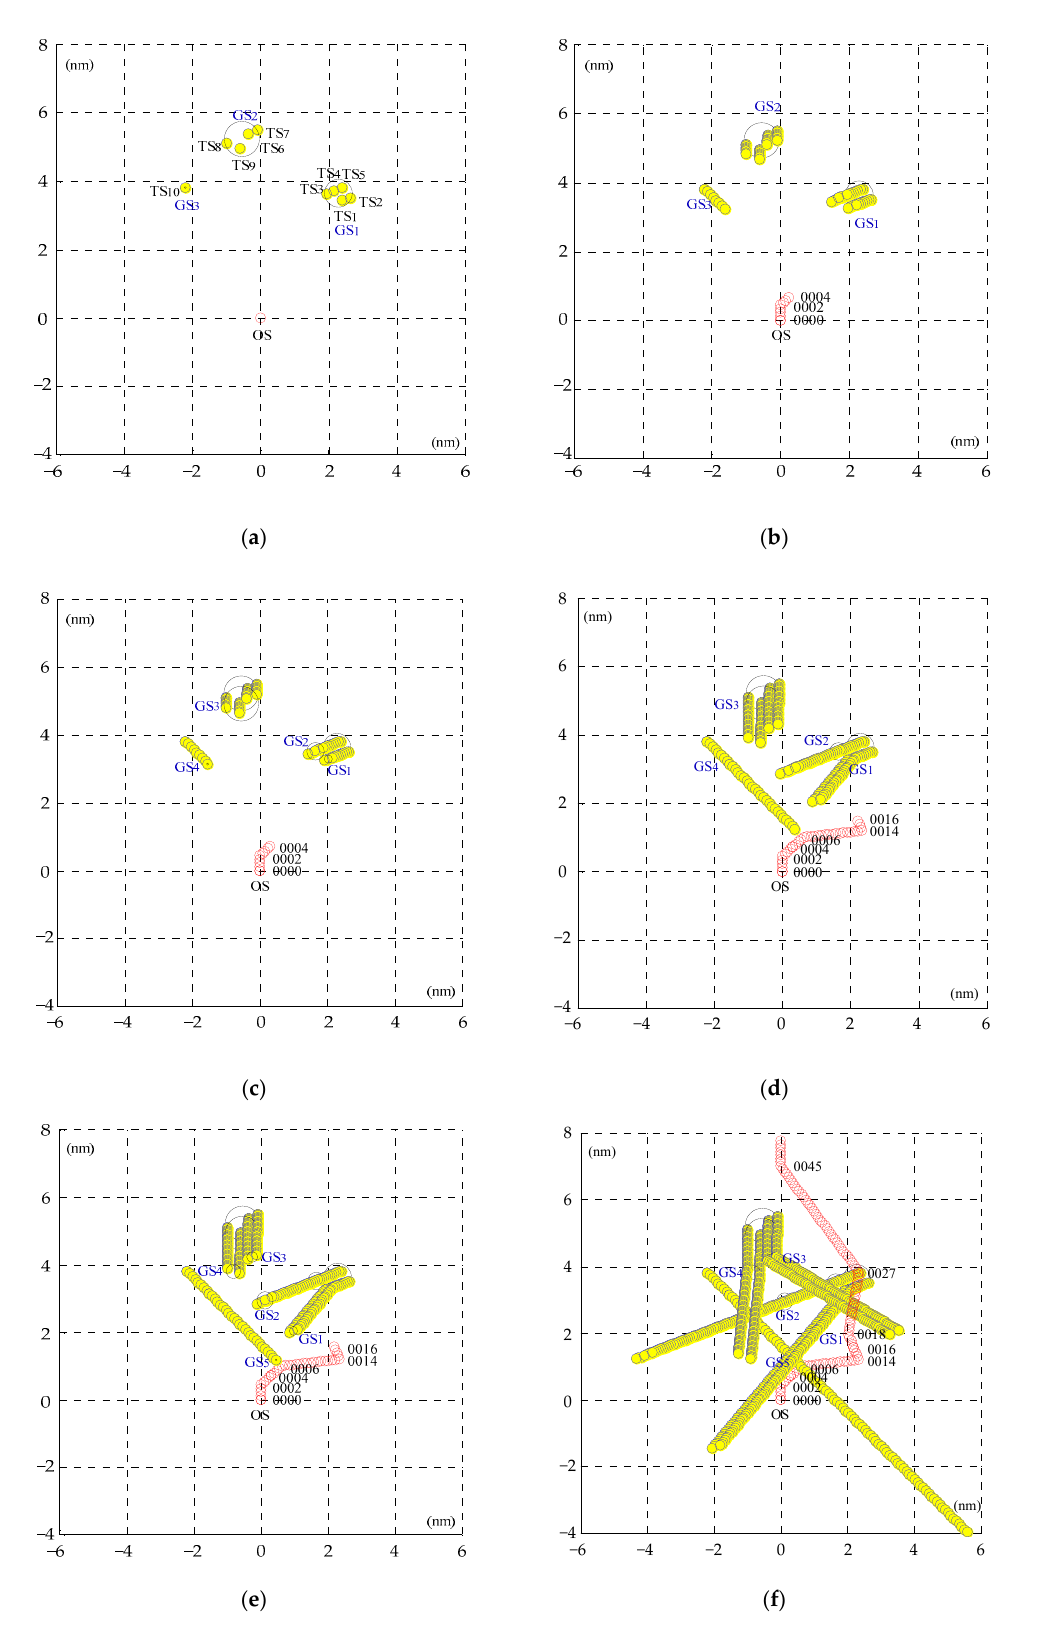
Figure 8. Simulation results: ( a ) Distribution of target ships and group ships at 0000; ( b ) ship trajectories (0000–0004); ( c ) distribution of target ships and group ships at 0004; ( d ) ship trajectories (0000–0016); ( e ) distribution of target ships and group ships at 0016; ( f ) ship trajectories (0000–0045).